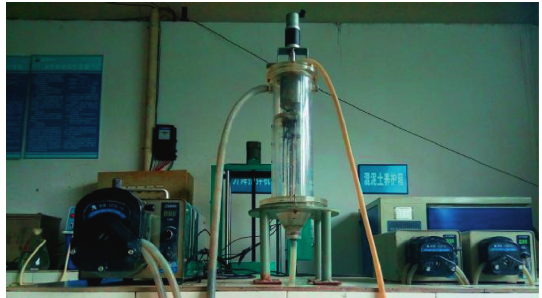
Figure 5: Dynamic thickening test